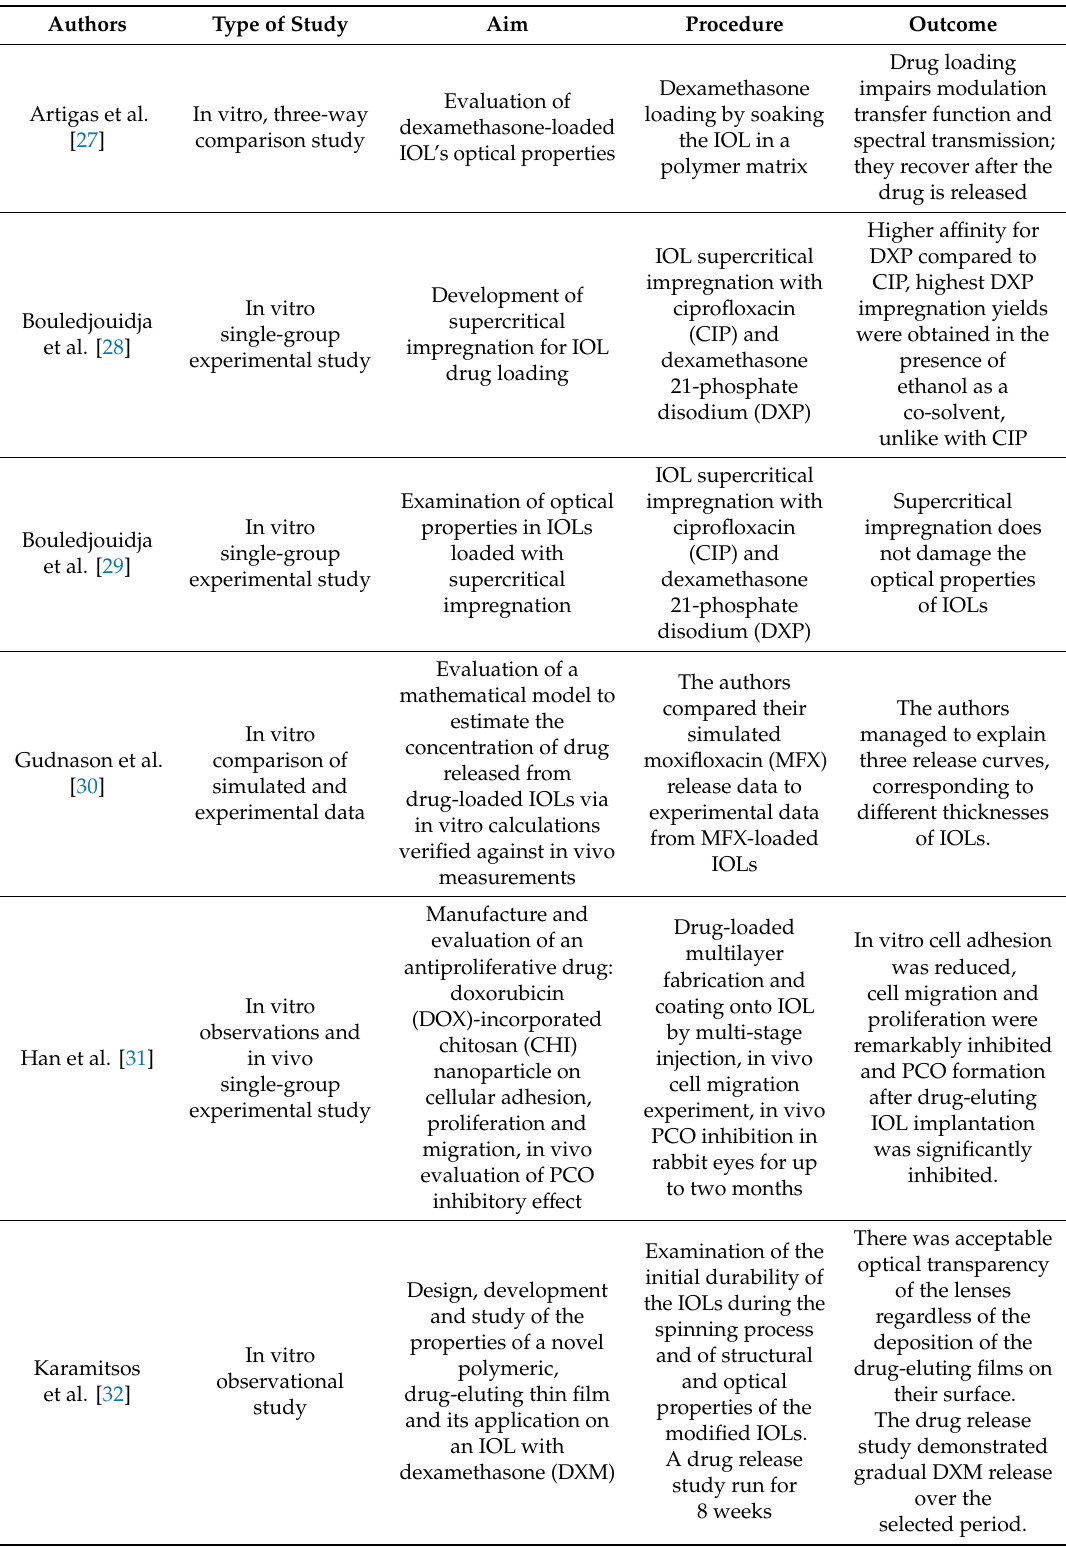
Table 1. Included studies relating to new methods for IOL loading with active molecules over the past